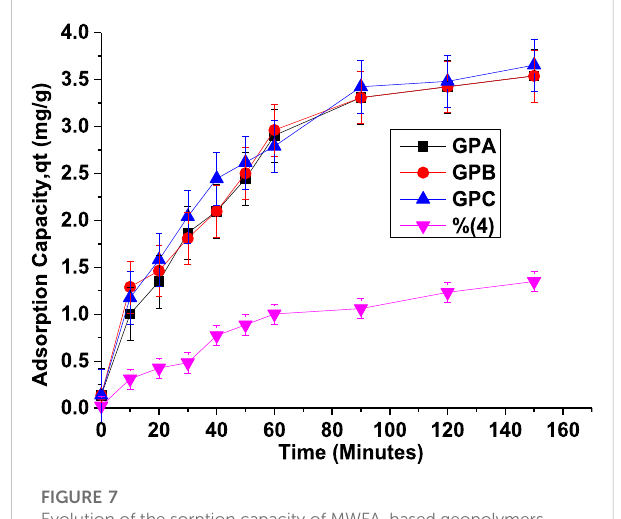
FIGURE 7 Evolution of the sorption capacity of MWFA-based geopolymers (GPA, GPB, GPC, and MWFA) for endosulfan with time (m = 0.1 g/ 50 mL, C i = 8 mg/L, and pH = 5).